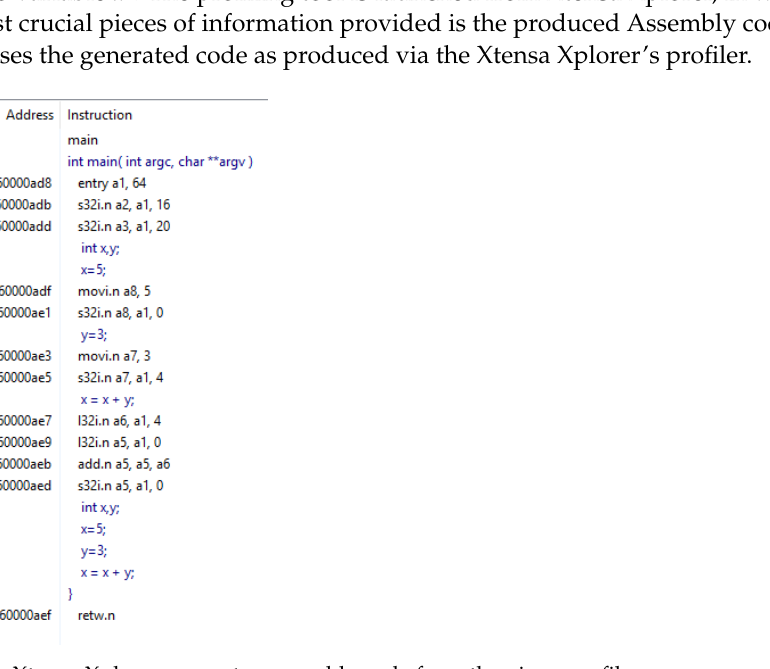
Figure 4. Xtensa Xplorer generates assembly code from the given